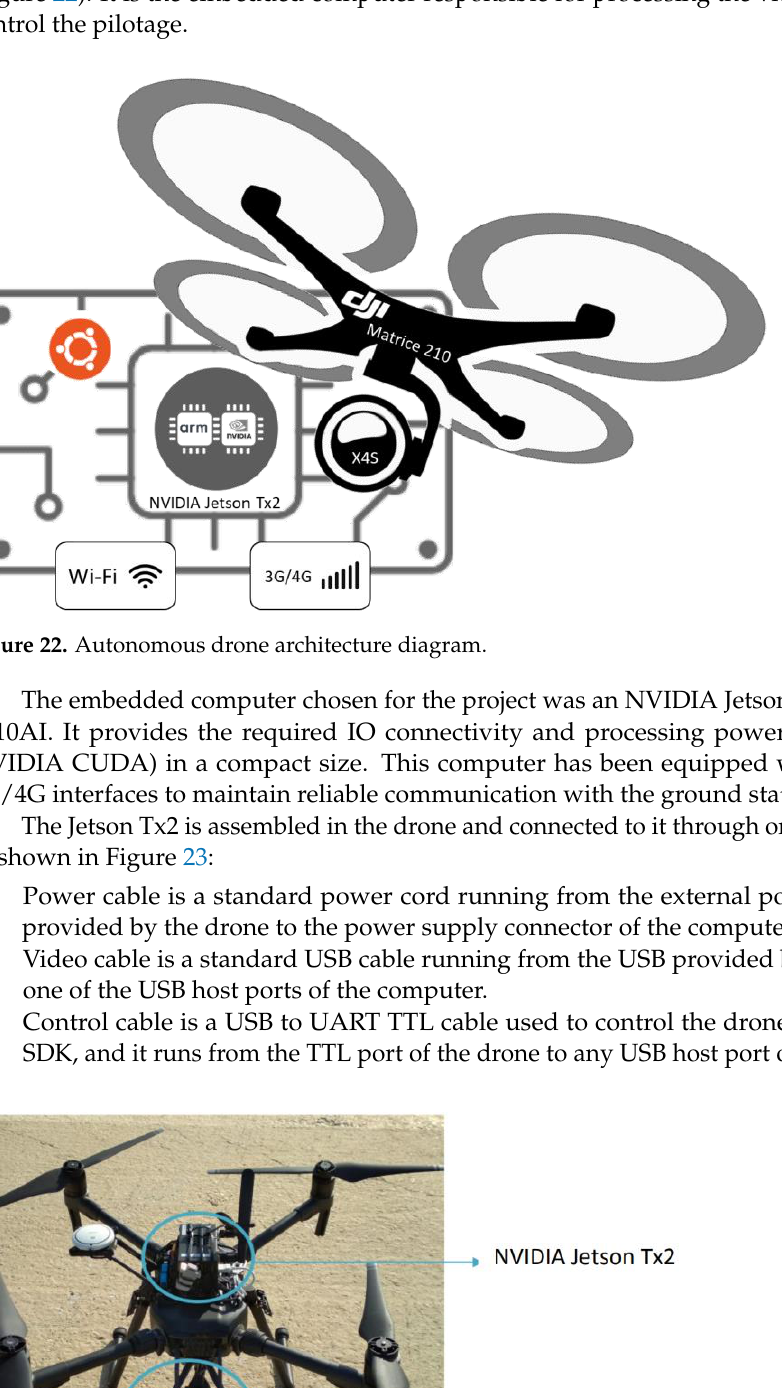
Figure 23. Drone and onboard computer assembly.